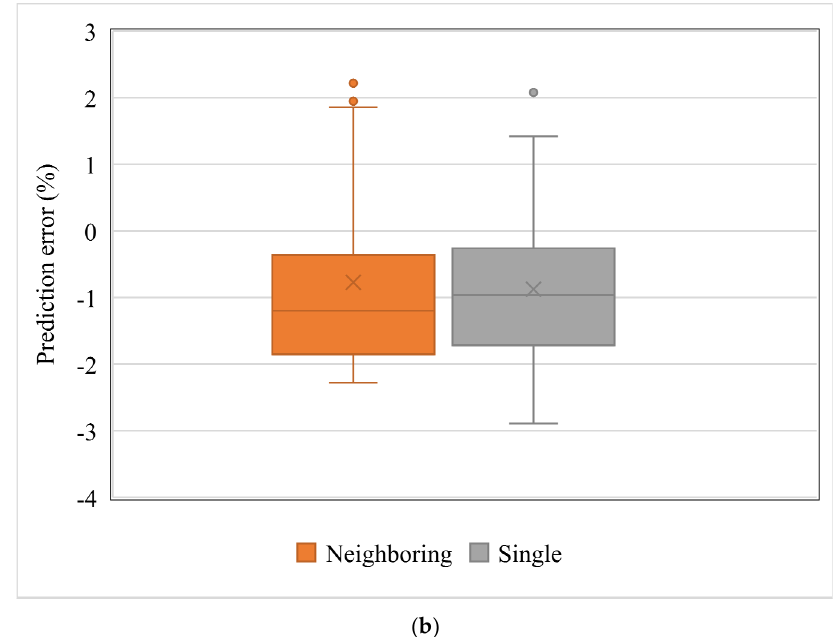
Figure 6. Influence of neighboring cross sections on SVR_P prediction errors: ( a ) scatter plot, and ( b ) box plot.